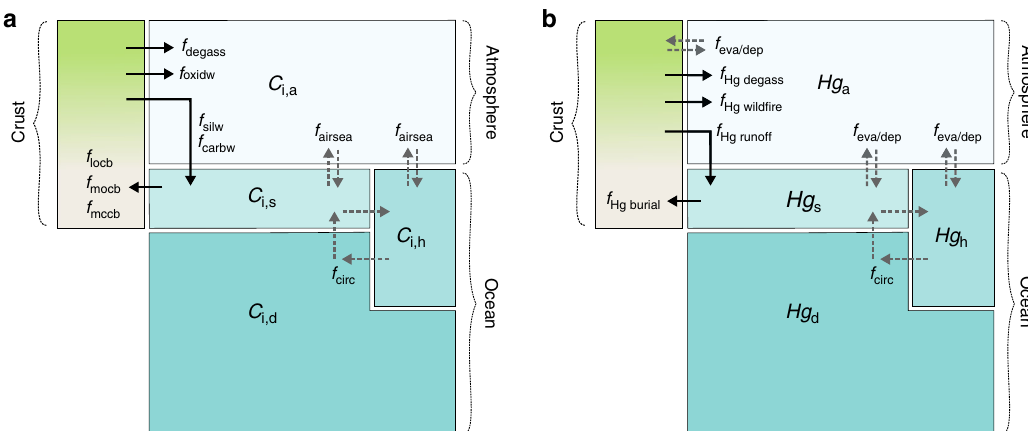
Fig. 2 Model schematic. Concentrations of modelled species are tracked in boxes representing the atmosphere (a), surface ocean (s), high-latitude ocean (h) and deep ocean (d). Exchange between boxes via air – sea exchange, circulation and mixing, or evasion and deposition are shown as dashed arrows. Biogeochemical fl uxes between the hydrosphere and continents/sediments are shown as solid arrows. See text, ‘ Methods' and Supplementary Information for full details of fl uxes. a C cycle. b Mercury